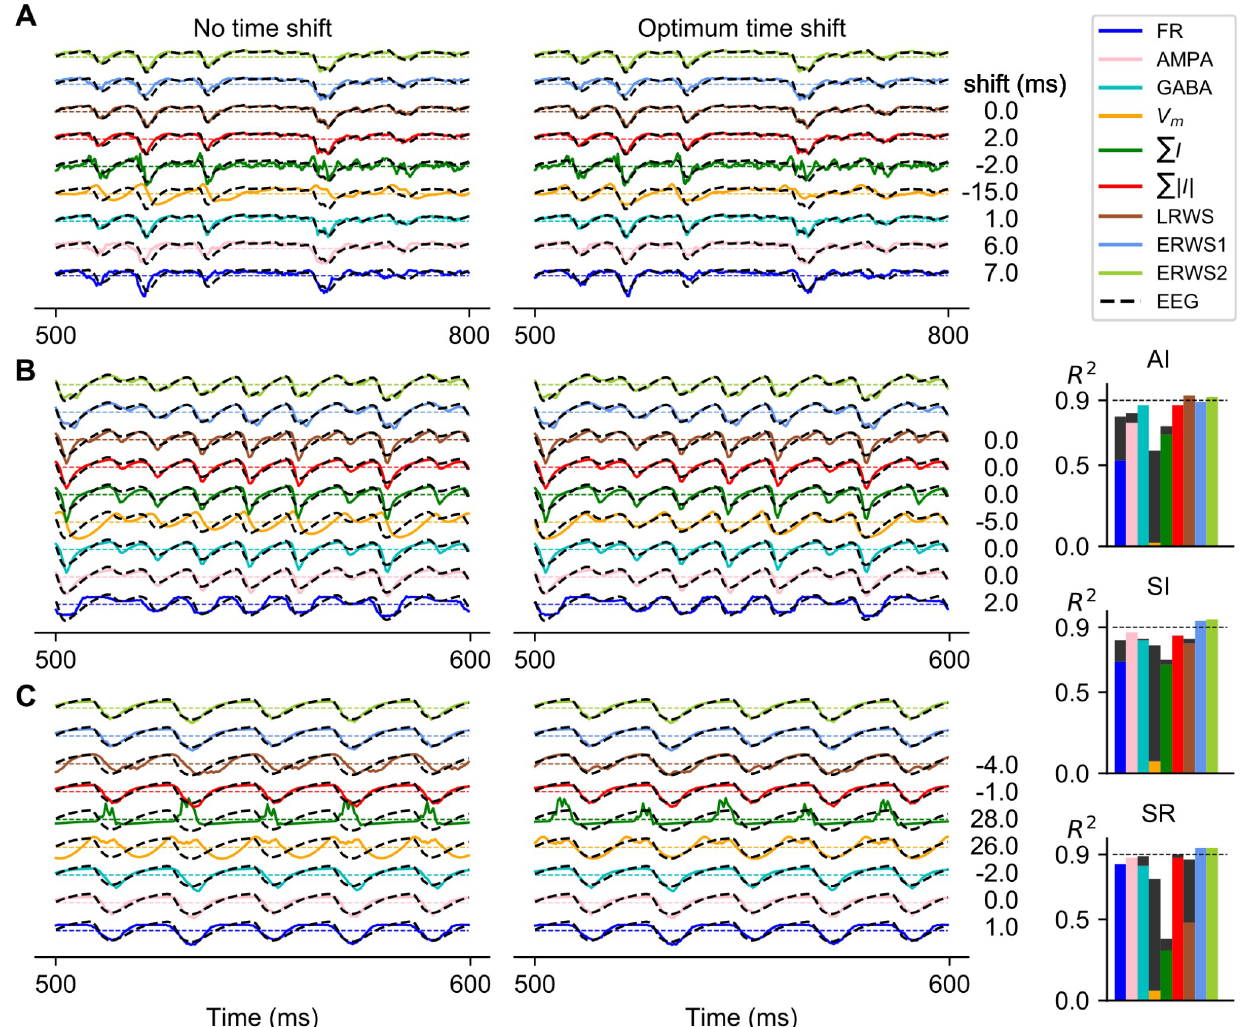
Fig 3. Optimum time shift of proxies that maximizes cross-correlation with the EEG. Comparison of the outputs of proxies and the ground-truth EEG before (left) and after (right) applying the optimum time shift, with the optimum time shift for each proxy and network state indicated on the right. Note that some proxies have positive time shifts for all network states (e.g., FR ), while others (e.g., GABA ) change the sign of the time shift when passing from the AI to the SR state. The network states shown are the following: AI in panel A, SI in panel B and SR in panel C. On the right: R 2 before (color bars) and after (black bars) applying the optimum time shift. ERWS1 and ERWS2 are not time shifted.